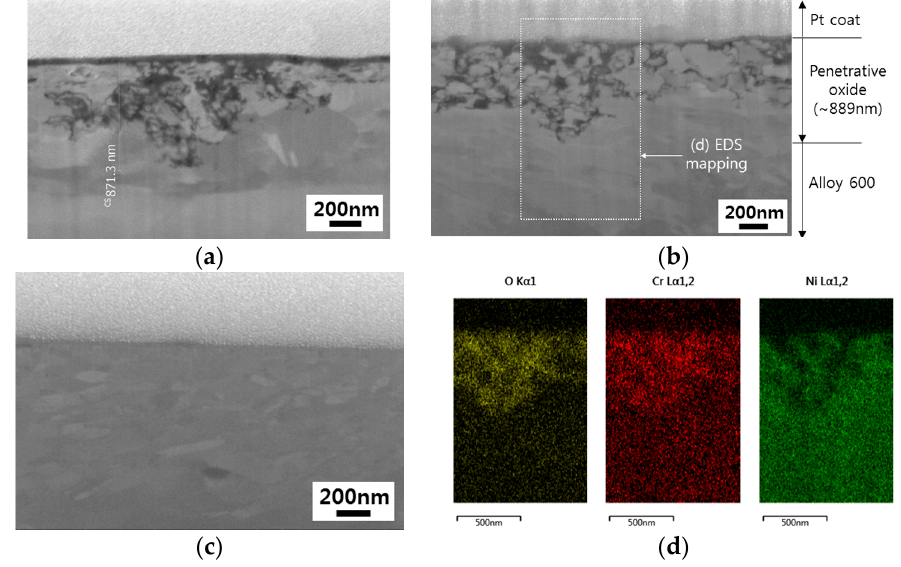
Figure 8. FIB/SEM images of cross-section near surface of the specimens tested for 100 h (38° tilted image, penetrative oxide depth were corrected by tilt angle): ( a ) Tube; ( b ) Rod; ( c ) Plate; ( d ) EDS mapping of area indicated in ( b ).